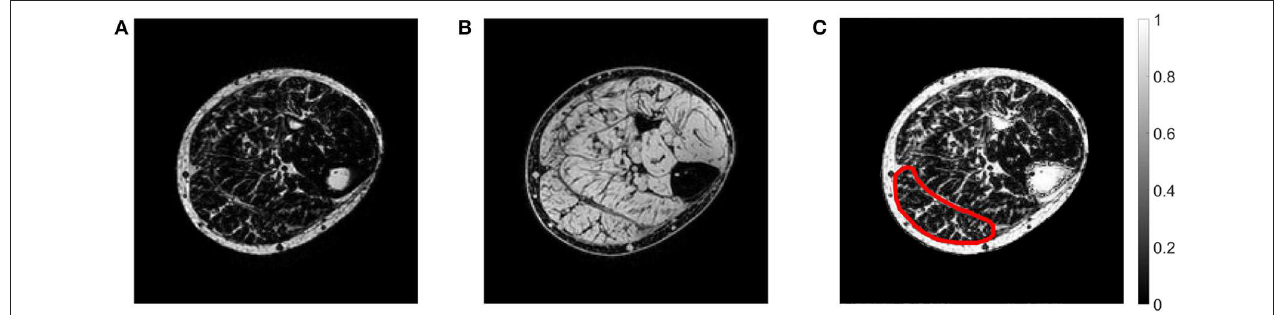
FIGURE 2 | Example of an axial mDixon image from the paretic leg of a stroke patient showing the (A) fat-saturated image, (B) water-saturated image, and (C) fat fraction map. In the fat fraction map, voxels with high fat fractions are white and voxels with low fat fractions are black. The slice is approximately midway between the ankle and the knee. The medial gastrocnemius muscle boundary has been